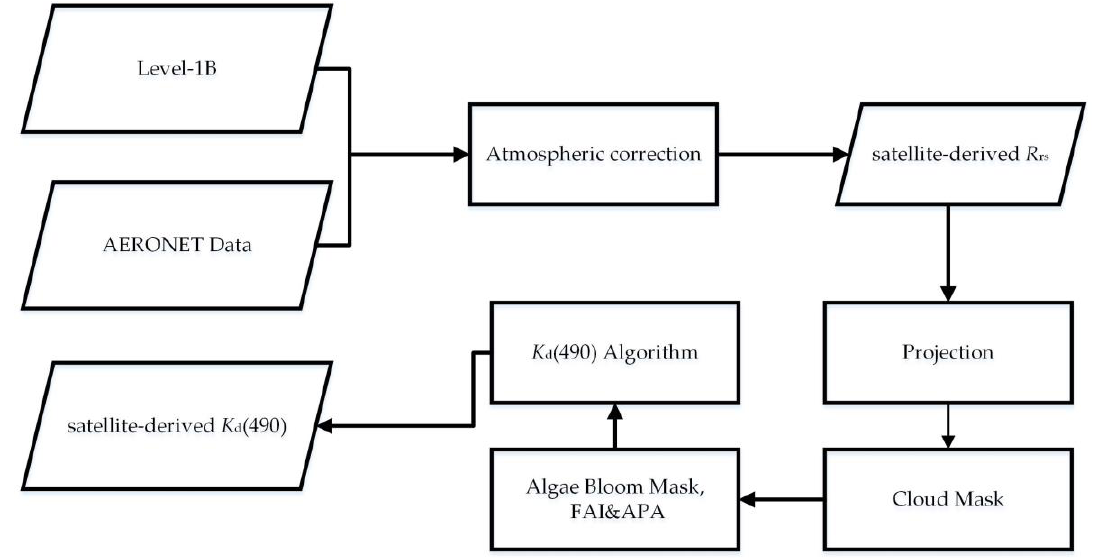
Figure 2. Processing procedure of the satellite-derived K d (490) product.